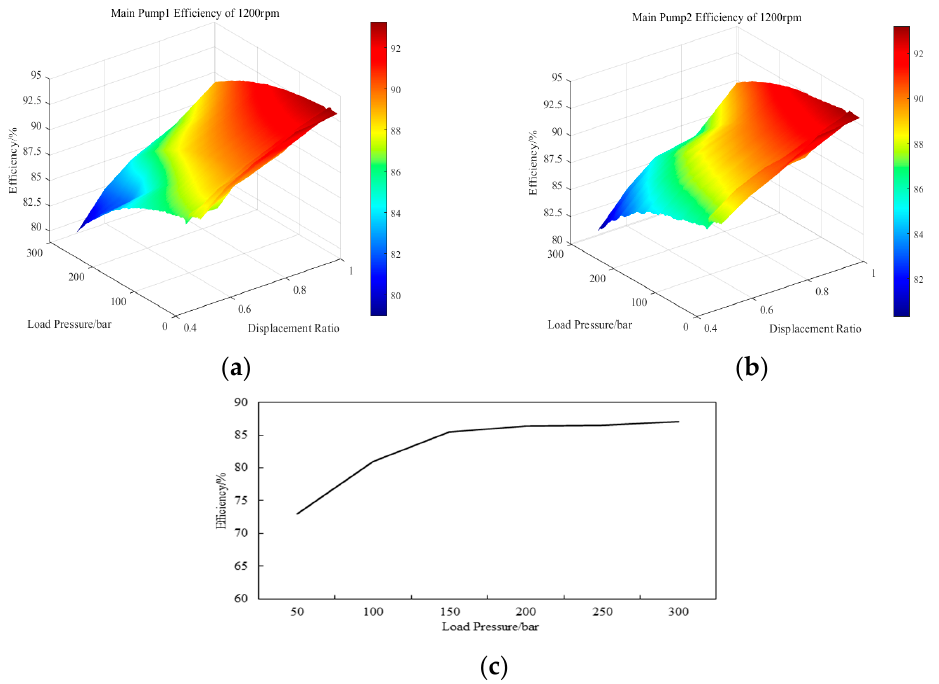
Figure 11. Efficiency results of hydraulic pumps at 1200 rpm. ( a ) Pump 1 displacement ratio-load-efficiency results; ( b ) pump 2 displacement ratio-load-efficiency results; ( c ) steering pump load-efficiency results.